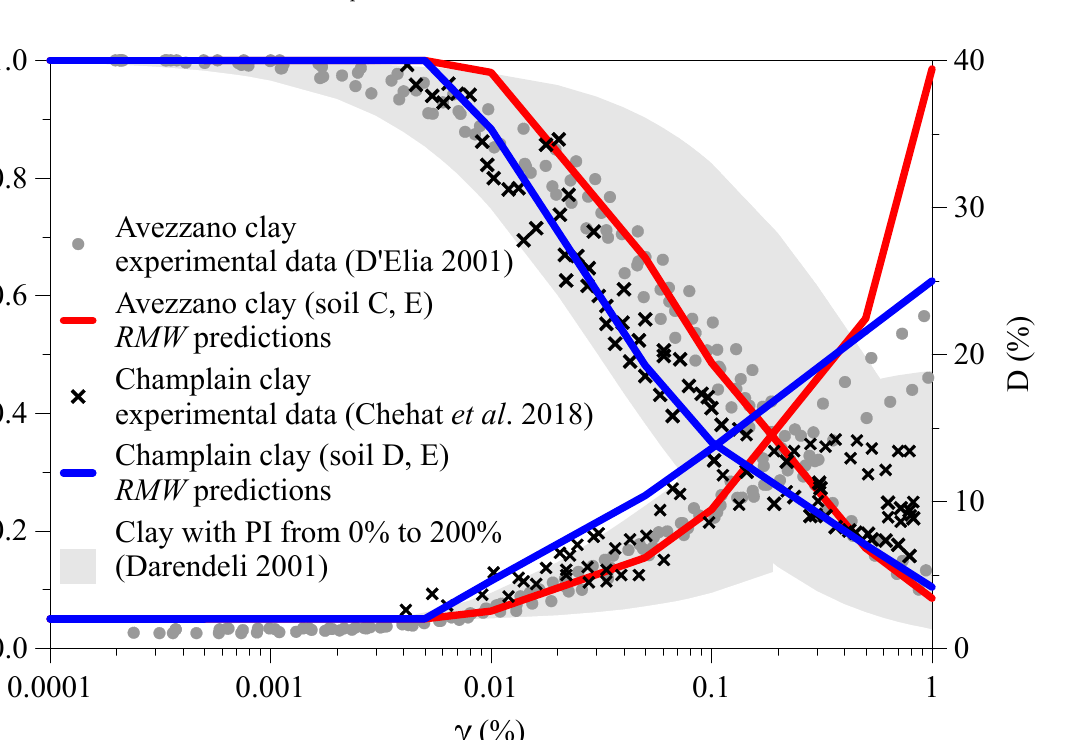
(%)0.0 0.0001 0.001 0.01 0.1 1 Figure 1. Shear modulus degradation and damping curves predicted by the RMW model for Avez- zano and Champlain clays, compared to laboratory data [37,38] and curves by Darendeli [48].